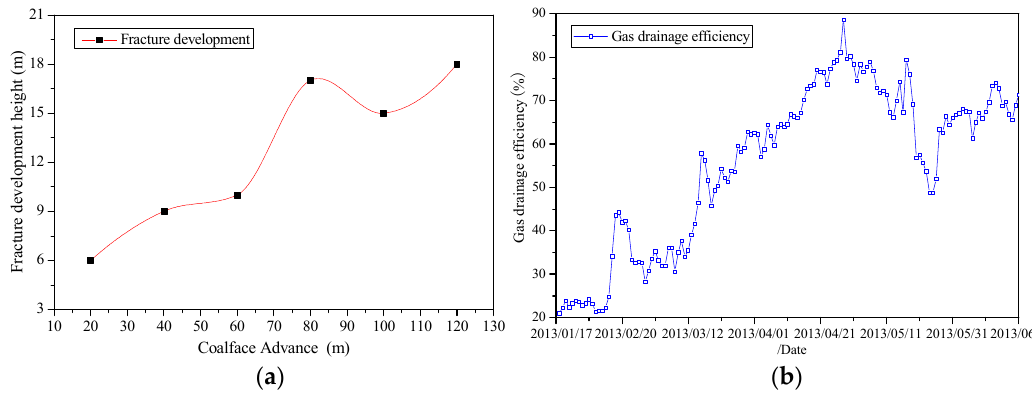
Figure 15. Overlying strata’s fracture development and gas extraction effect: ( a ) fracture development; ( b ) gas extraction effect.